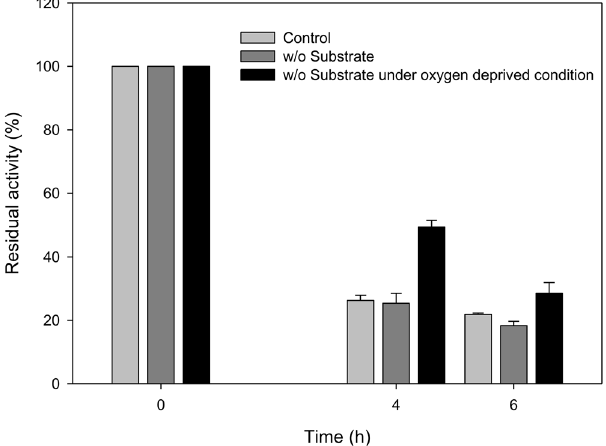
Figure 2. The in vitro activity of E6BVMO, which was prepared from the cells taken out at t = 0, 4, and 6 h during the biotransformation shown in Fig. 1. The second and the third bars indicated the in vitro activities of E6BVMOs, which were prepared during the biotransformations without the reaction substrate under aerobic condition and without the reaction substrate under oxygen-deprived condition, respectively. The E6BVMO activity at t = 0 was 0.056 U/mg proteins. The experiments were performed in triplicate. The error bars indicate standard